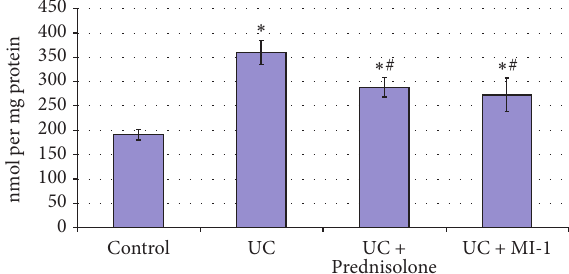
Figure 7: Bowel mucosa MDA concentrations for rats experiencing UC and treated with Prednisolone and MI-1. ∗ 𝑝 ≤ 0.05 compared with control group; # 𝑝 ≤ 0.05 compared with UC